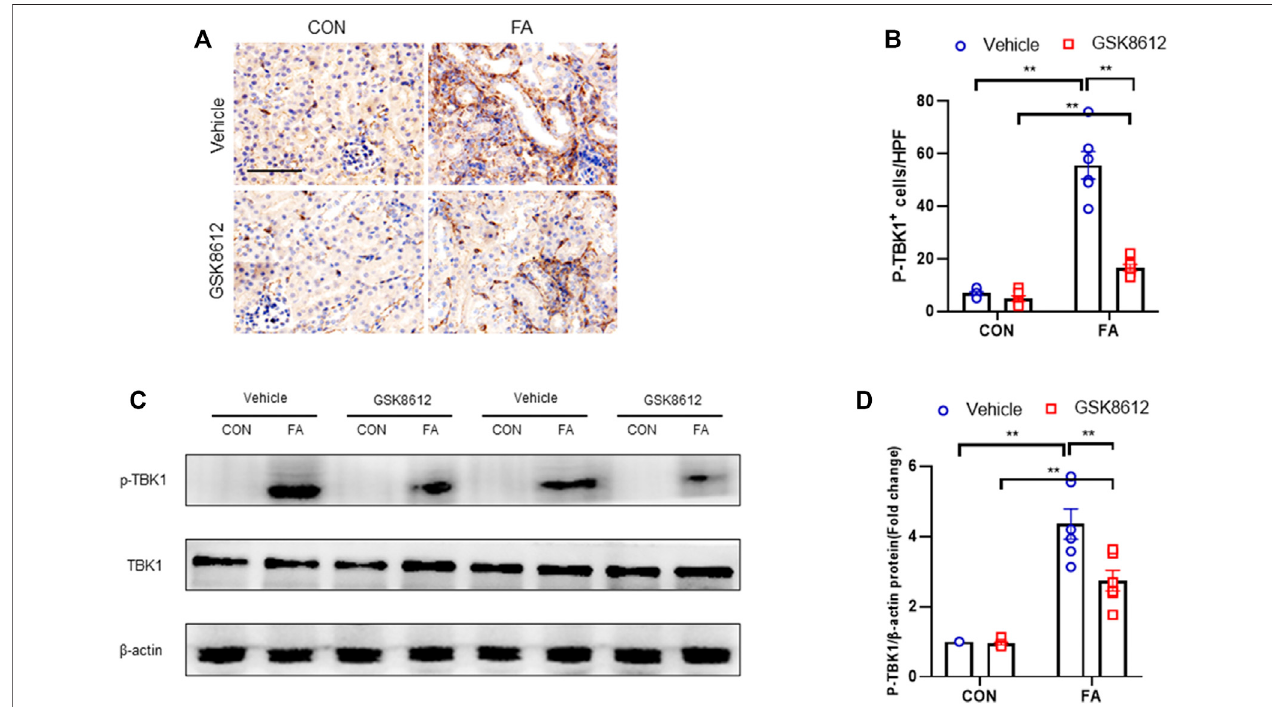
FIGURE 5 | GSK8612 treatment inhibits TBK1 activation in FA nephropathy. (A) Representative photomicrographs of kidney sections in each group stained for p-TBK1 (brown). (B) Quantitative analysis of p-TBK1 positive cells in the kidneys. (C) Representative western blots show TBK1 protein levels in the kidneys in each group. (D) Quantitative analysis of TBK1 protein expression in the kidneys. ** p < 0.01; n = 6 in each group; Scale bar: 50 μ m.